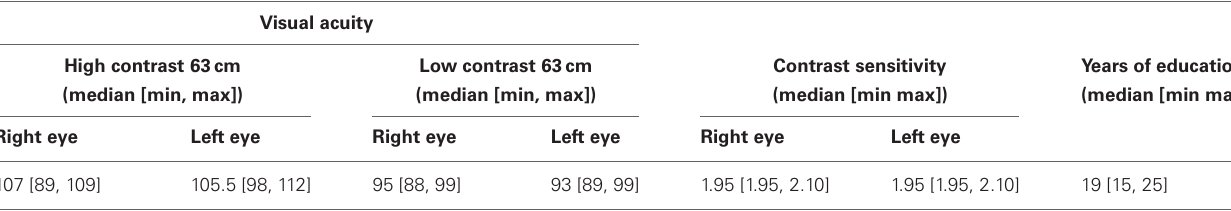
Table 2 | Pinhole experiment subjects’